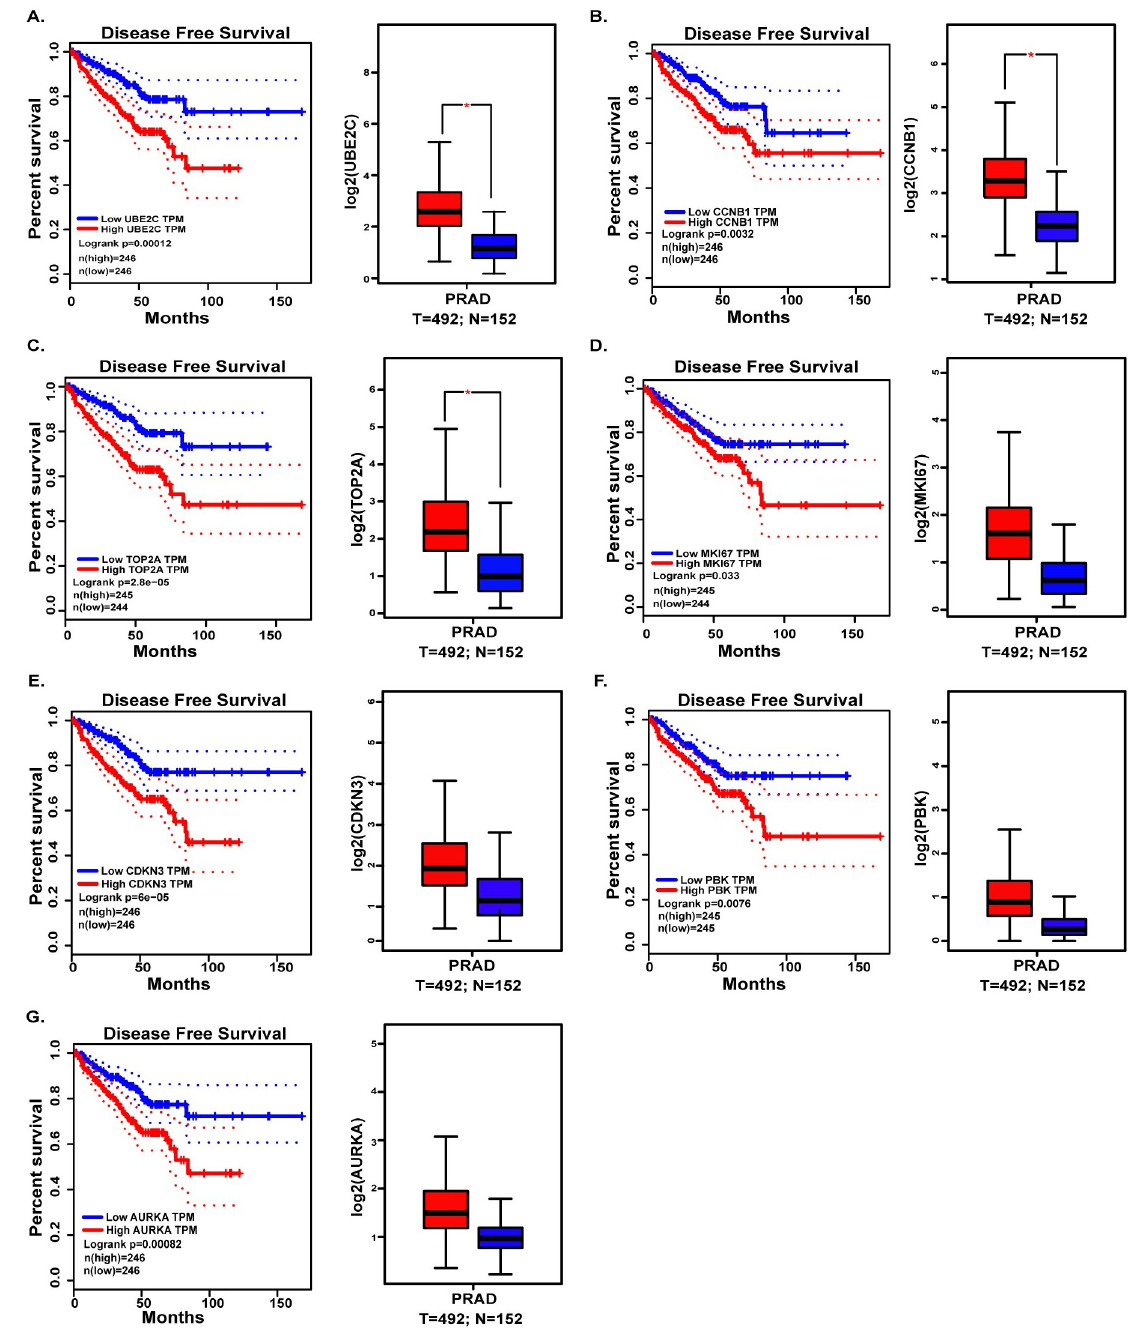
Fig 4. Validation the expression and disease-free survival (DFS) of candidate hub genes in TCGA. (A) UBE2C. (B) CCNB1. (C) TOP2A. (D) MKI67. (E) CDKN3. (F) PBK. (G)